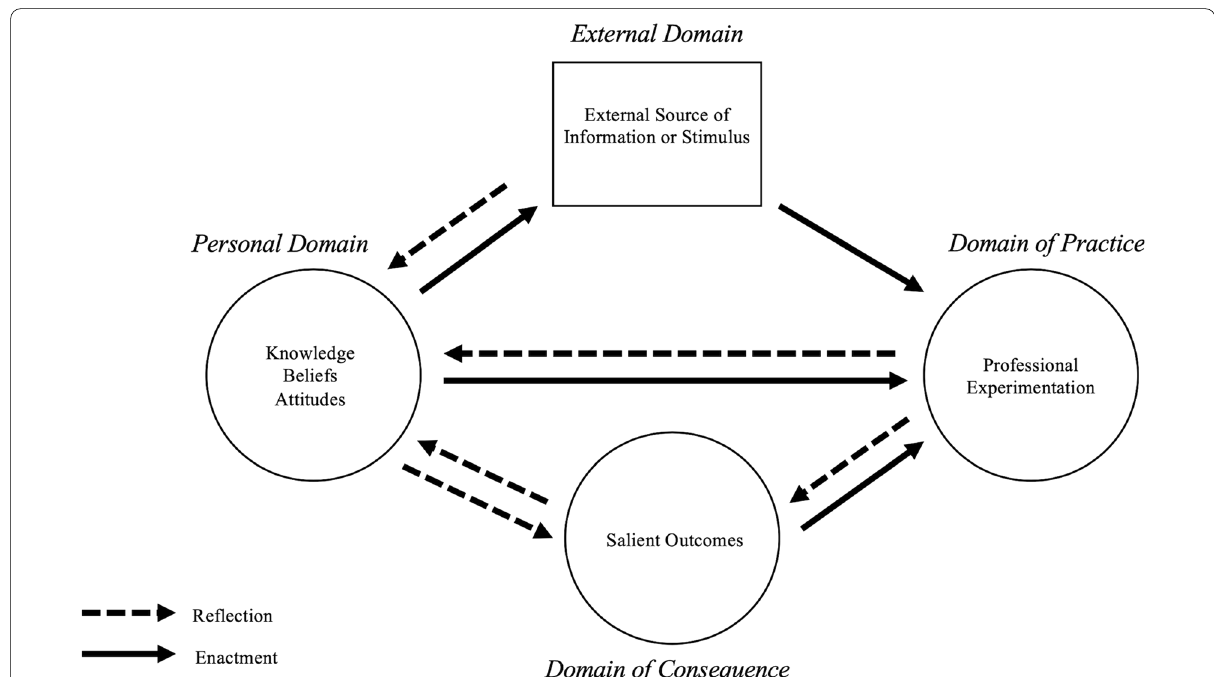
Fig. 1 The adapted Interconnected Model of Professional Growth. IMPG figure adapted from Clarke and Hollingsworth (2002), Perry and Boylan